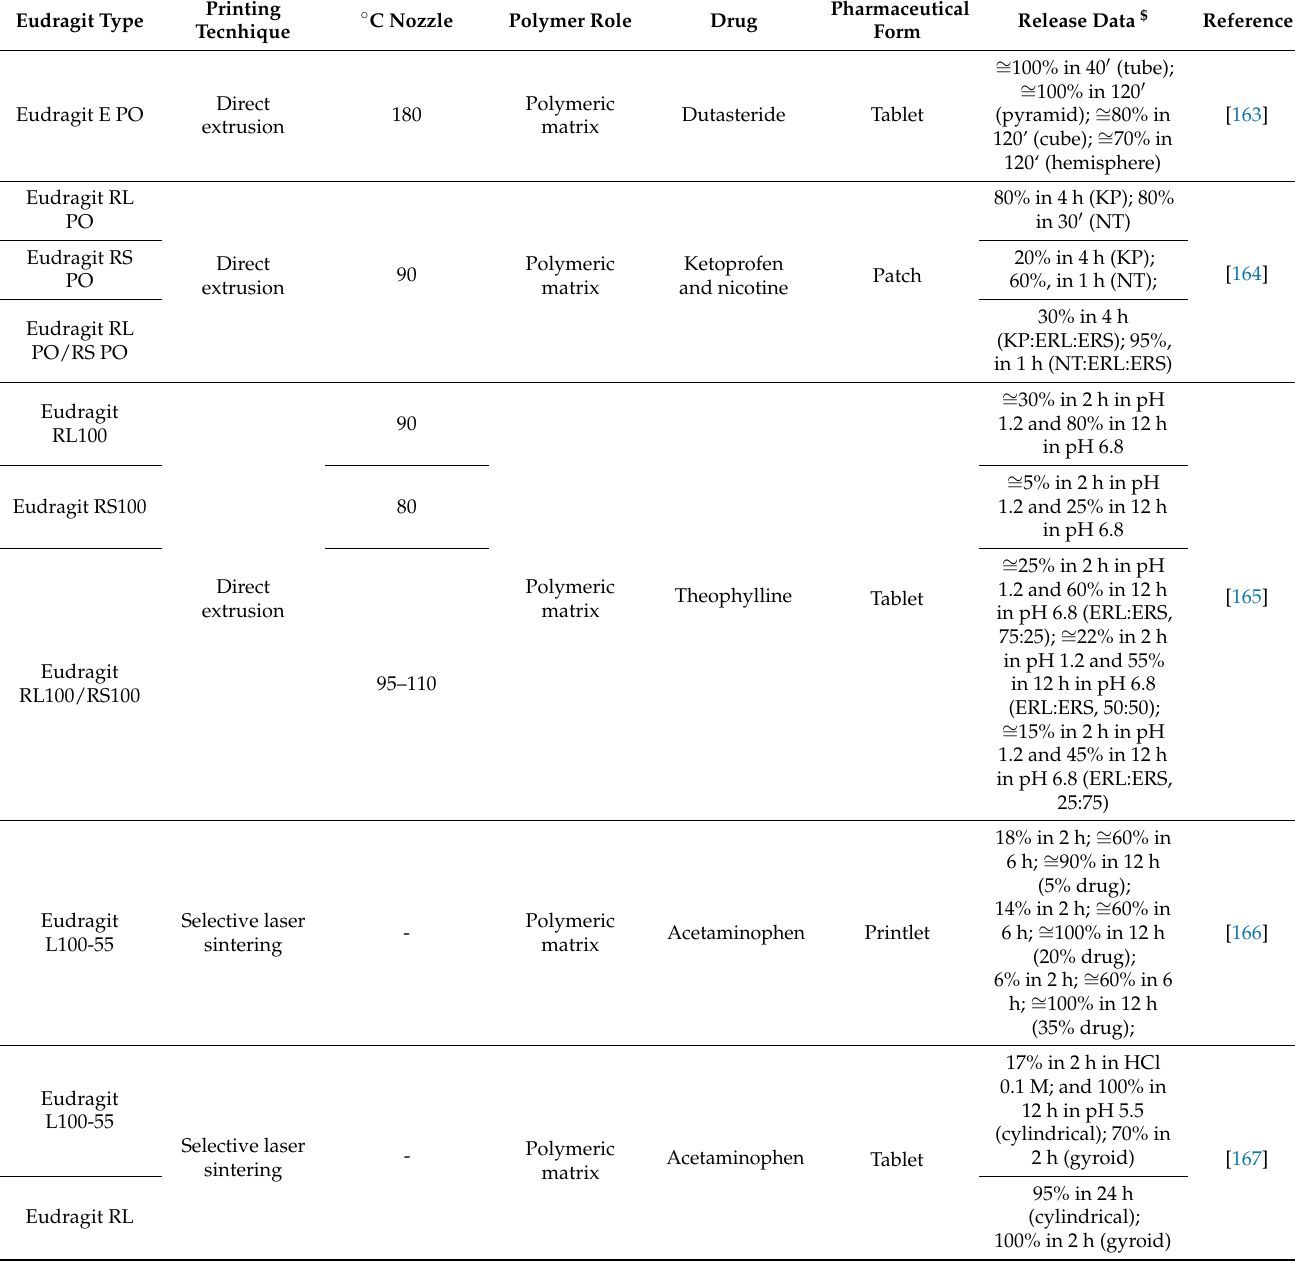
Table 6. 3D printed products by techniques other than FDM using Eudragit